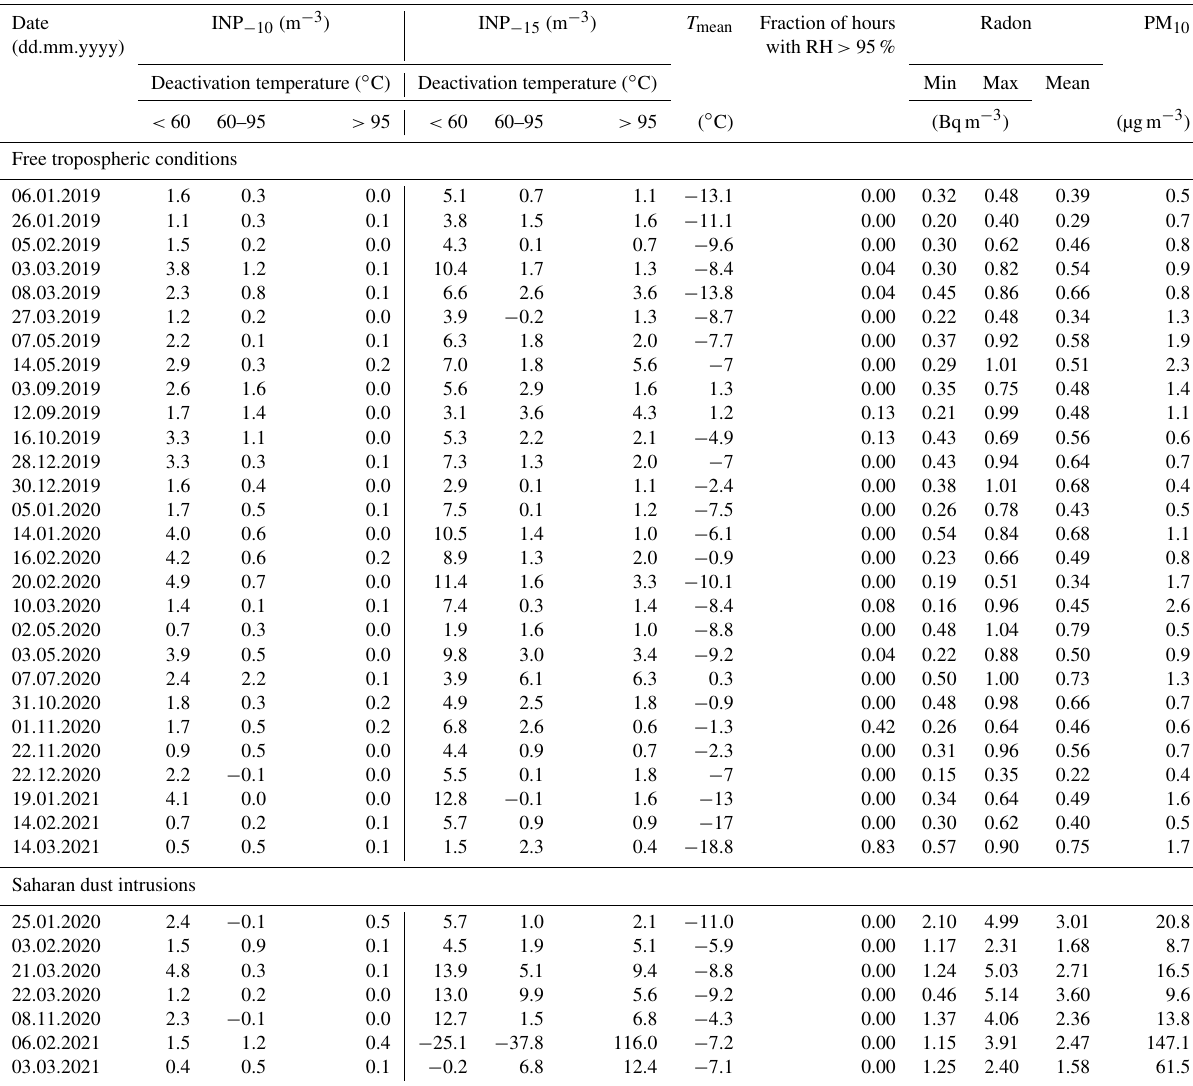
Table A1. Number concentration of ice-nucleating particles active at − 10 ◦ C (INP − 10 ) and at − 15 ◦ C (INP − 15 ) at Jungfraujoch, determined for free tropospheric conditions and during Saharan dust intrusions. The same sample material was analysed three times. A first freezing assay was followed by a heat treatment (10min at 60 ◦ C) and second freezing assay, followed by a second heat treatment (10min at 95 ◦ C) and a third freezing assay. All steps were carried out in an uninterrupted operation. Blank values were subtracted from raw measured values. Three categories of INPs were derived by calculating the difference between the INP number concentration before and after each heat treatment, resulting in negative values if the INP concentration had increased after a heat treatment. Meteorological data are from MeteoSwiss, and PM 10 data are from the Swiss National Air Pollution Monitoring Network